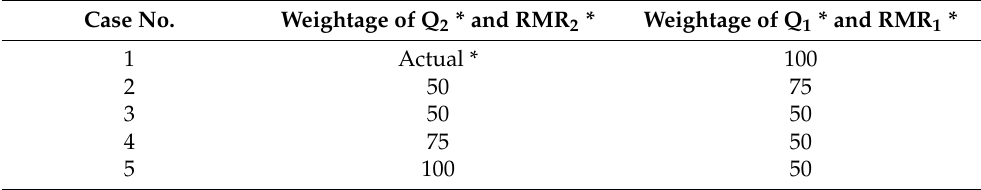
Table 6. Different weights selected for the rock-mass-quality back calculation. Case No.